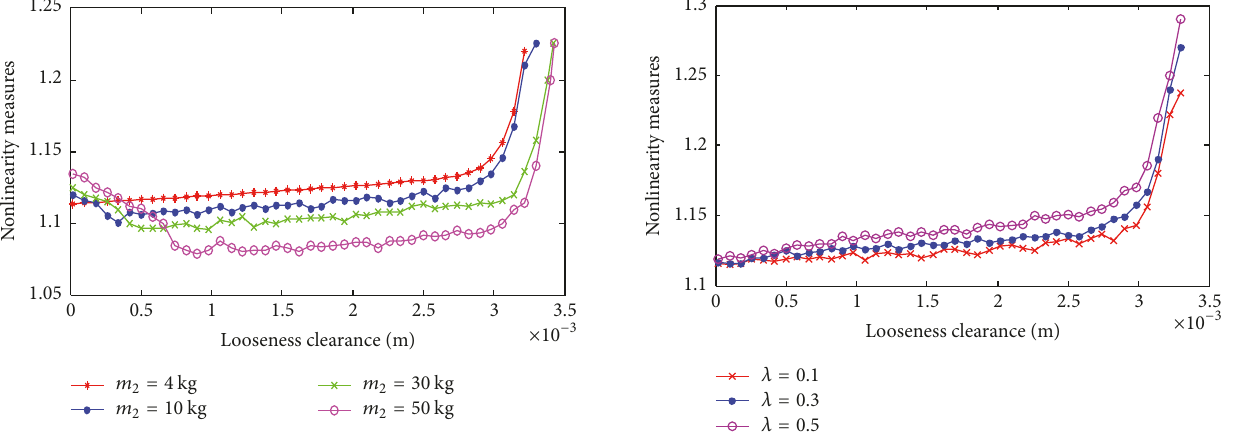
Figure 16: Curves of nonlinearity measure and looseness clearances with different amplitude